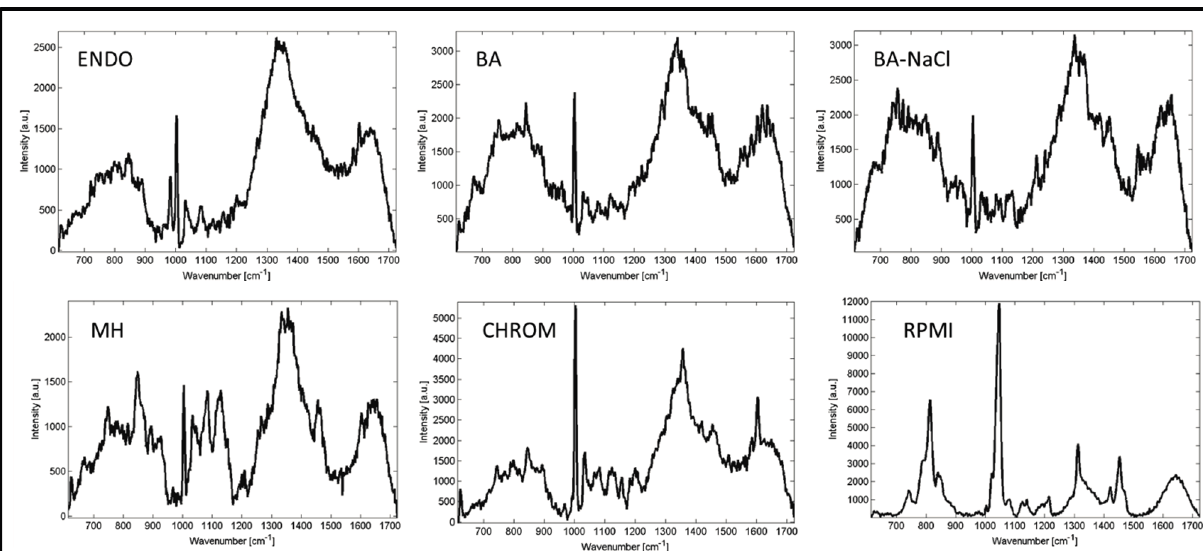
Figure 1. Raman spectra obtained from different culture media (ENDO—Endo agar, BA—blood agar; BA-NaCl—blood agar with 10% NaCl; MH—Mueller-Hinton agar;